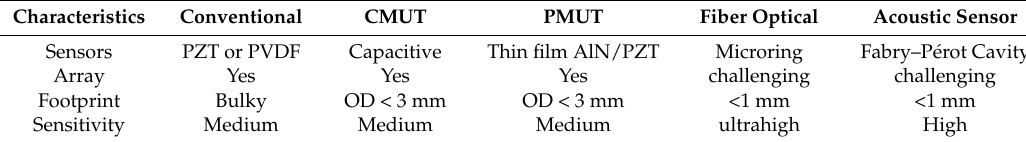
Table 1. Conventional and microelectromechanical systems (MEMS) based acoustic transducers.